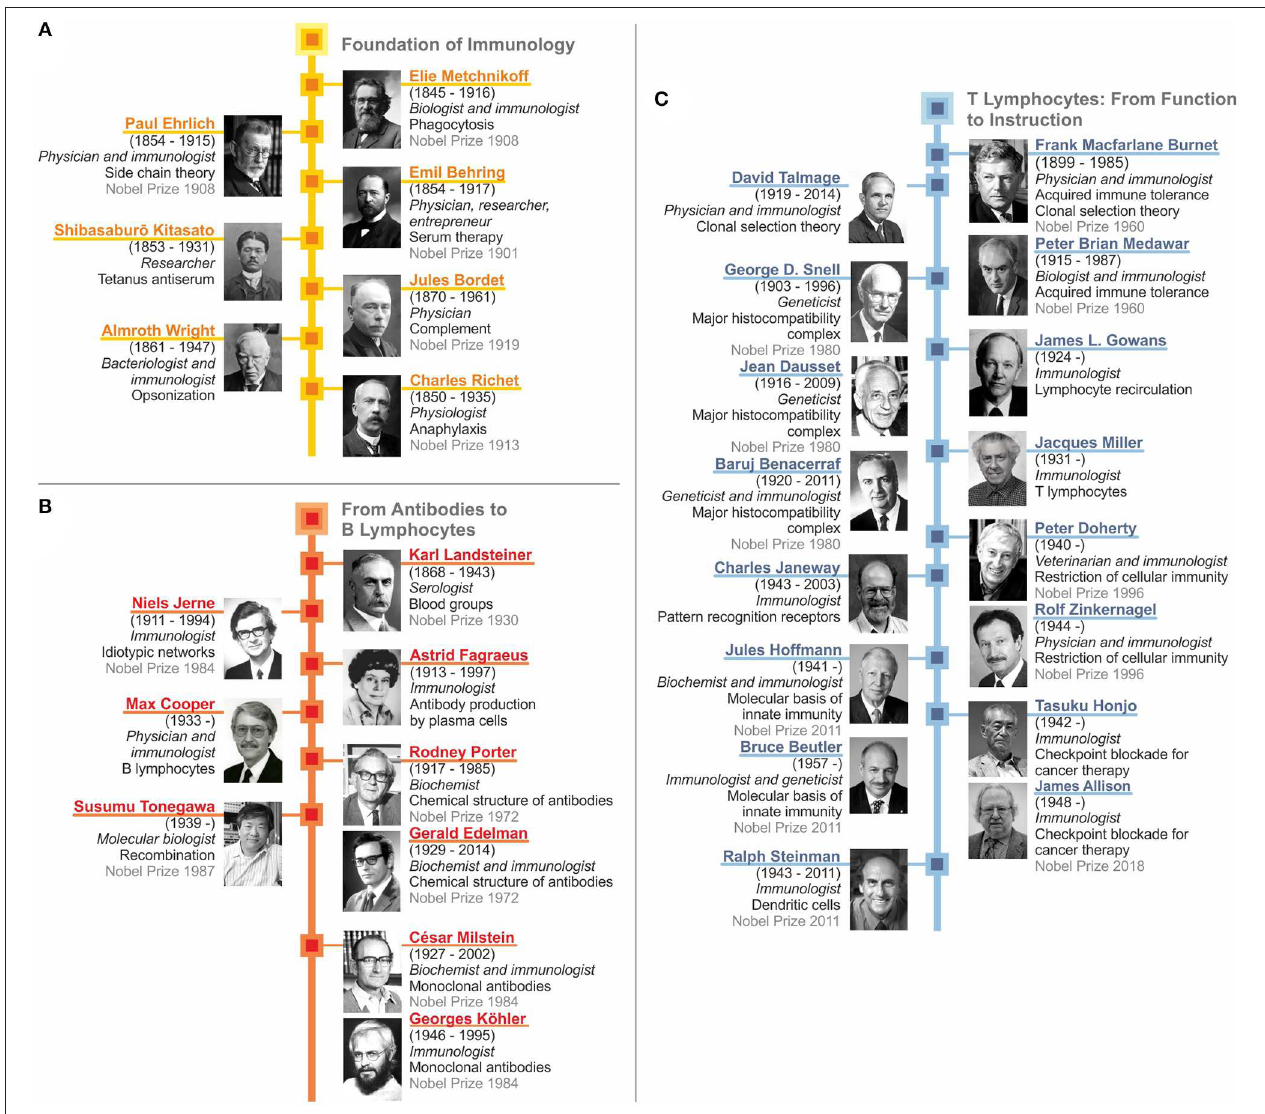
FIGURE 7 | Recap of immunology: from serum therapy to checkpoint control. (A) Foundation of immunology. (B) From antibodies to B lymphocytes. (C) T lymphocytes: from function to instruction.